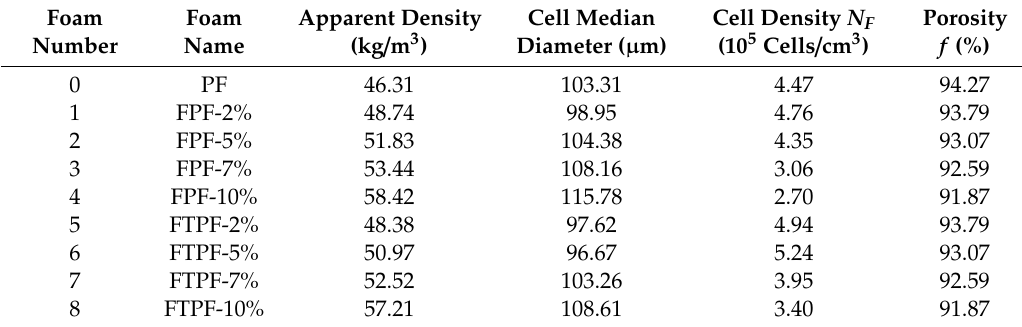
Table 2. Apparent density, cell median diameter, cell density, and porosity of foams